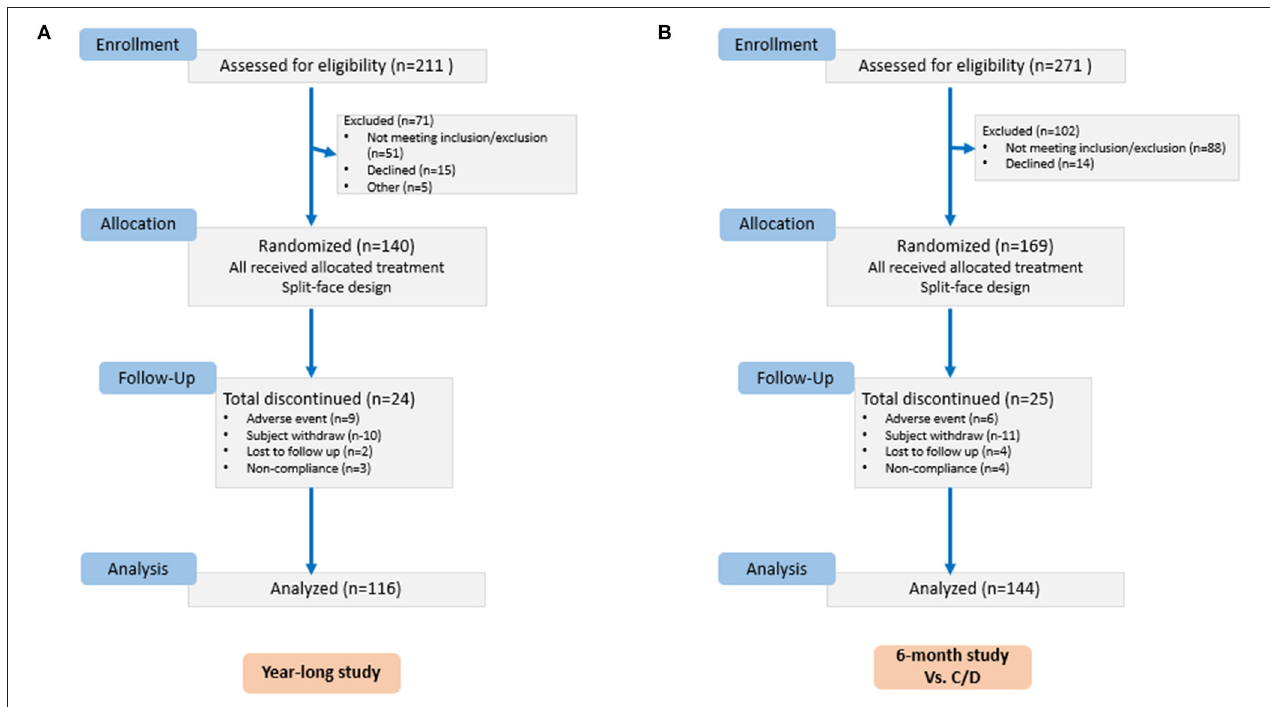
FIGURE 3 | Study details of clinical trial #2 (A) and #3 (B) .